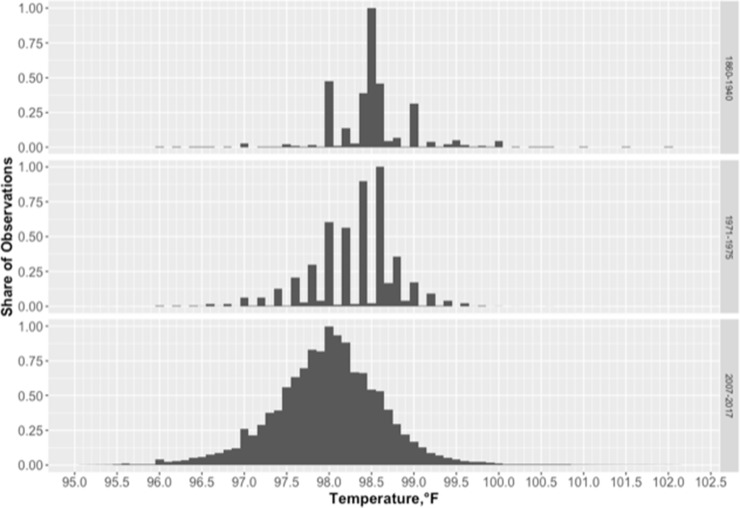
Distribution of temperature measures (oF) for each cohort: UAVCW (1860–1940), NHANES I (1971–1975) and STRIDE (2007–2017).Figure 1—figure supplement 1—source code 1.R code for Figure 1—figure supplement 1.